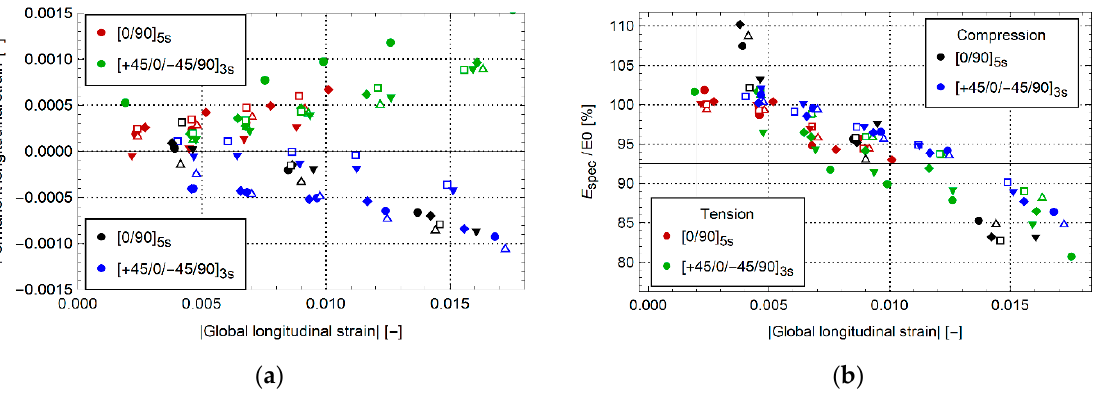
Figure 12. ( a ) Permanent strain and ( b ) normalized elastic modulus for [0/90] 5s and [+45/0/ − 45/90] 3s.